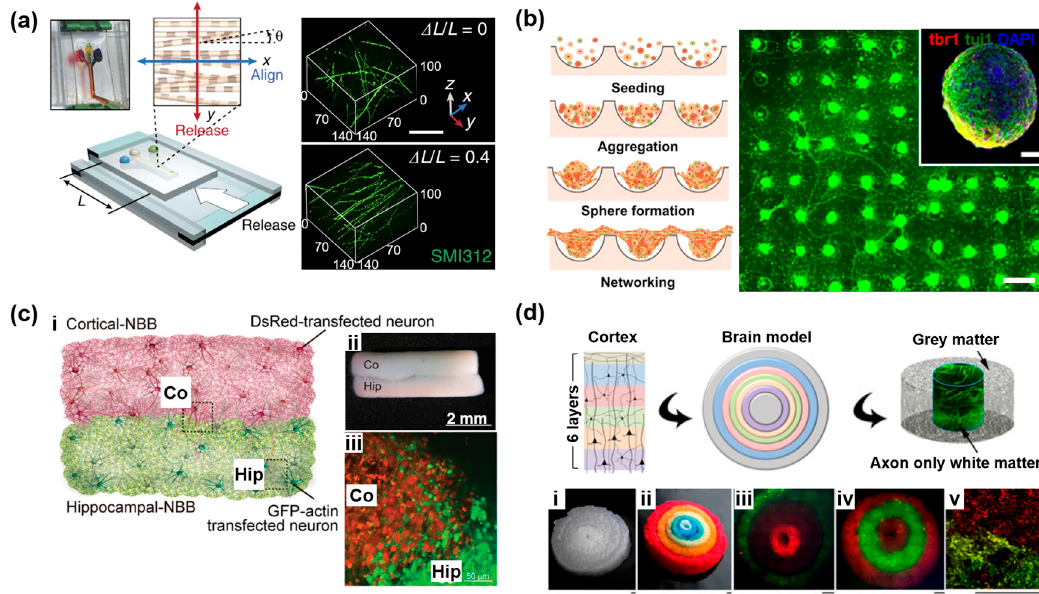
Figure 2. 3D neural network on the microdevice. ( a ) Schematic diagram and confocal microscopy image of reconstruction of an anisotropically organized hippocampal neural network. Reproduced with permission [37]. Copyright 2017, Nature Publishing Group; ( b ) Formation of a networked neurosphere model in the PDMS micro-concave wells. Reproduced with permission [56]. Copyright 2013, Elsevier; ( c ) Neural pathway formation by the assembly of different types of neural building blocks (NBBs). ( i ) Schematic illustration of axonal extensions between NBBs. ( ii ) Stereomicroscopic image of NBB assembly of cortical-NBB (Co) and hippocampal-NBB (Hip). ( iii ) Fluorescence image of an assembled NBB, using Cell Tracker green labeled cortical-NBB and Cell Tracker red labeled-hippocampal-NBB. Reproduced with permission [57]. Copyright 2012, Royal Society of Chemistry; ( d ) 3D assembled cortex mimicked tissue structures. ( i,ii ) Six layered donuts of silk scaffold with original ( i ) and dyed color ( ii ), ( iii – v ) two three-layered cortical neuron constructs, ( v ) neurons at the interface. (Scale bar: 1 mm). Reproduced with permission [39]. Copyright 2013, National Academy of Sciences of the United States of America.